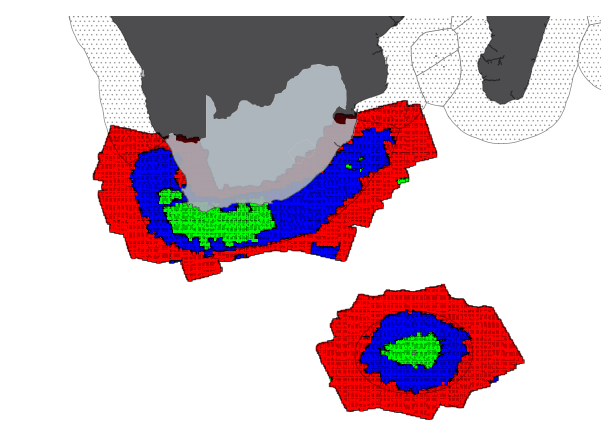
Figure 6. SAR Image Coverage in 2018 (Radarsat-2 only). Where Green, Blue and Red represent High, Medium, Low coverage respectively.